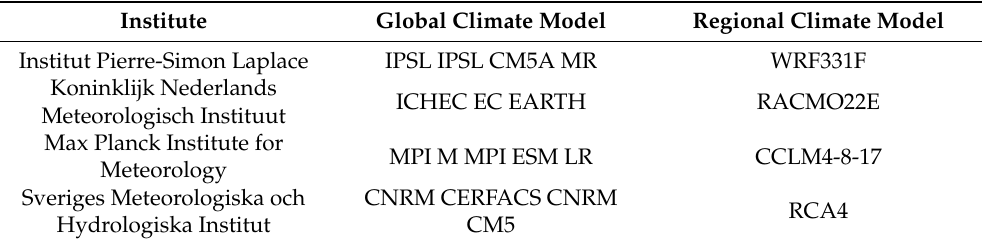
Table 1. Ensemble of Global Climate Model—Regional Climate Model (GCM-RCM) chains selected for this study [36], along with the corresponding institute that undertook each model